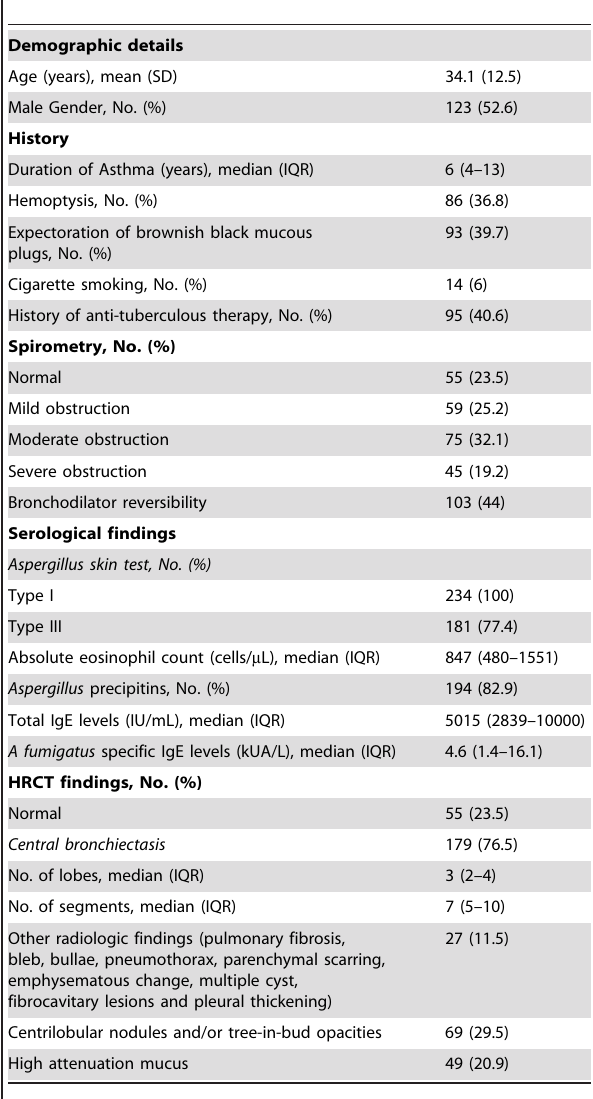
Table 1. Baseline characteristics including spirometry, serological and HRCT findings (n=234).